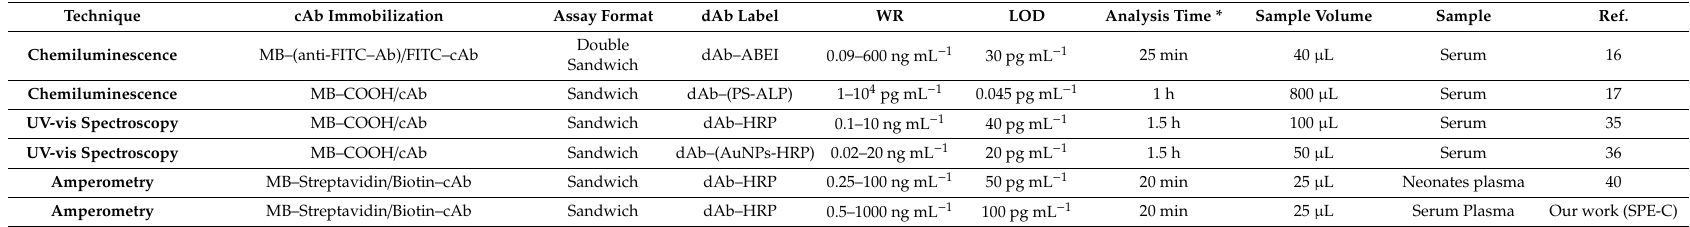
Table 4. Overview of magneto-immunosensors for PCT determination.